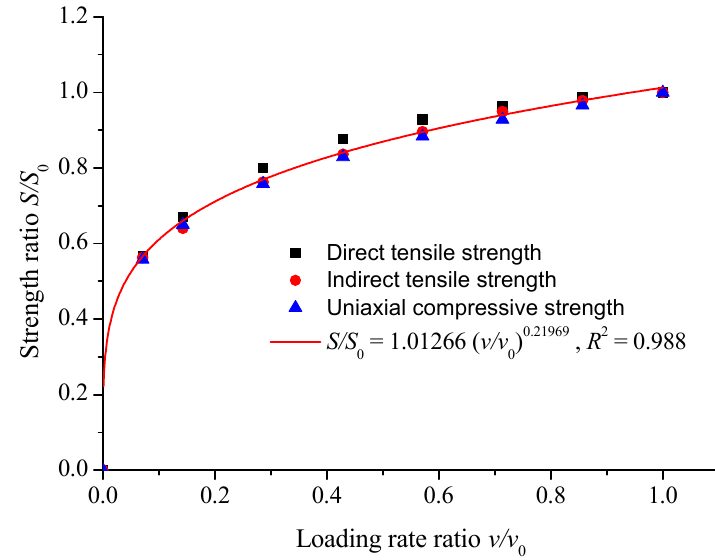
Figure 9. Strength ratio versus loading rate ratio under various loading modes.